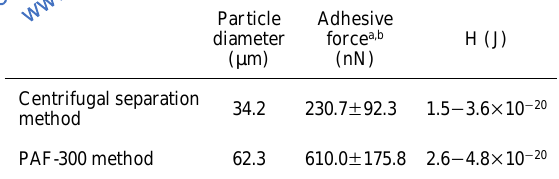
Table 4 Comparison of Centrifugal Separation Method and PAF- 300